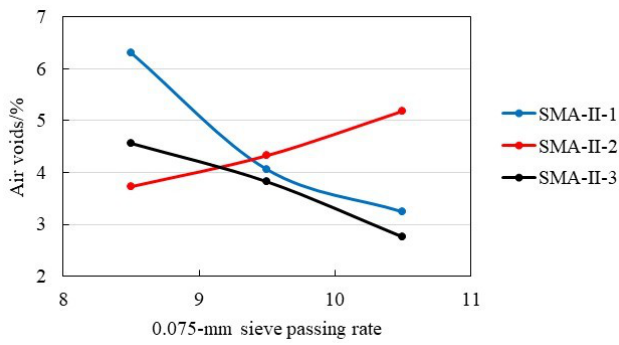
Figure 8. Change curves of the air voids of SMA- Ⅱ -1, SMA- Ⅱ -2 and SMA- Ⅱ -3.